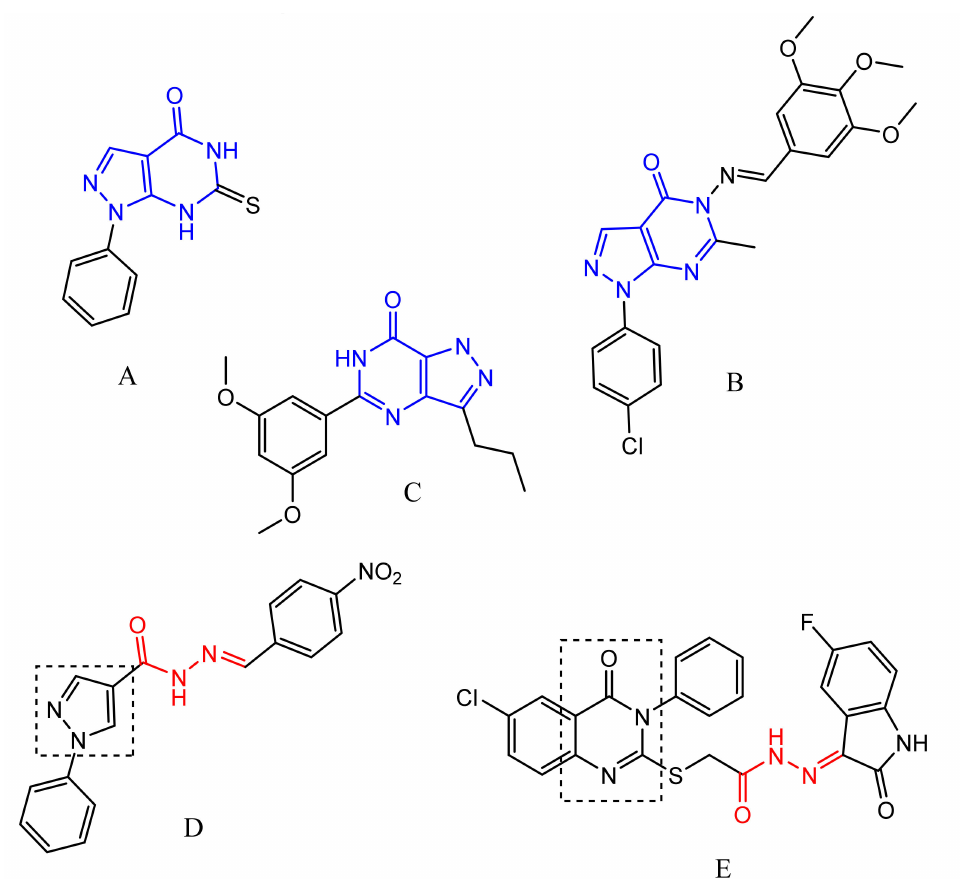
Figure 1. Previously reported cytotoxic compounds: pyrazole-fused pyrimidinones ( A – C ); hydrazide-hydrazones linked to either pyrazole ( D ) or pyrimidine ( E